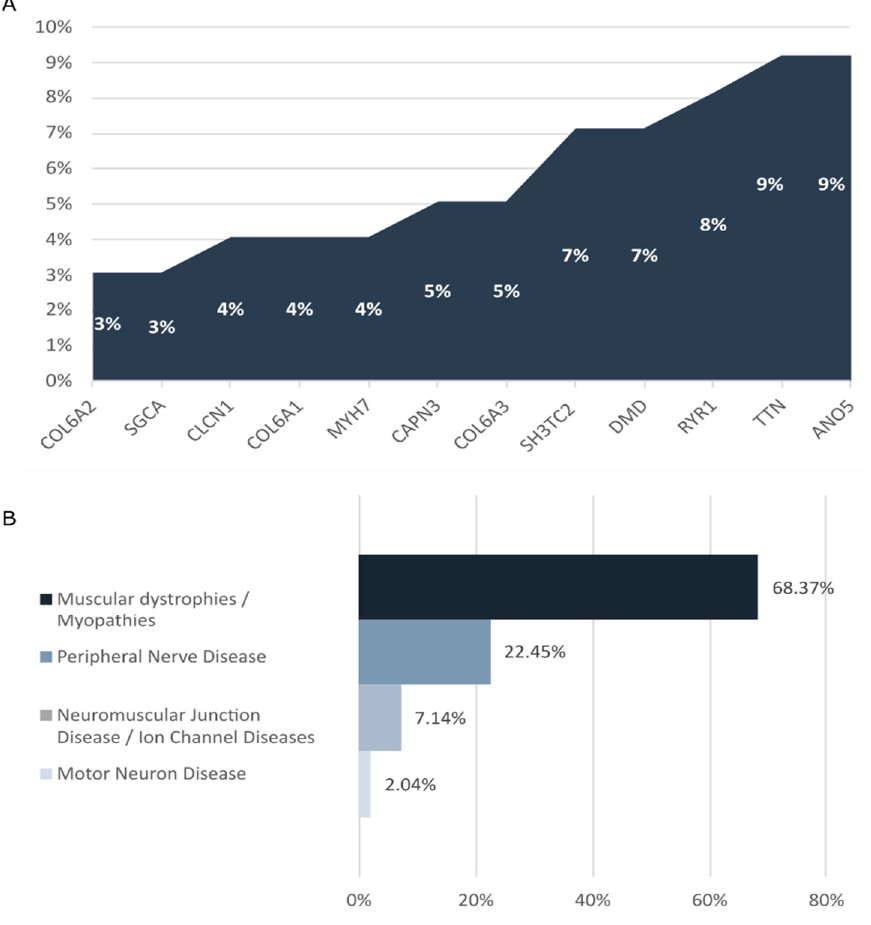
Figure 2. ( A ) Genes detected with high frequency in diagnosed patients analyzed with the INMD panel. Graph depicts the proportion of clinical cases for which a pathogenic/likely pathogenic variant was identified in the causative gene. ( B ) INMDs identified in our cohort. Copy number variants (CNVs) were identified in six patients (Figure 3). A